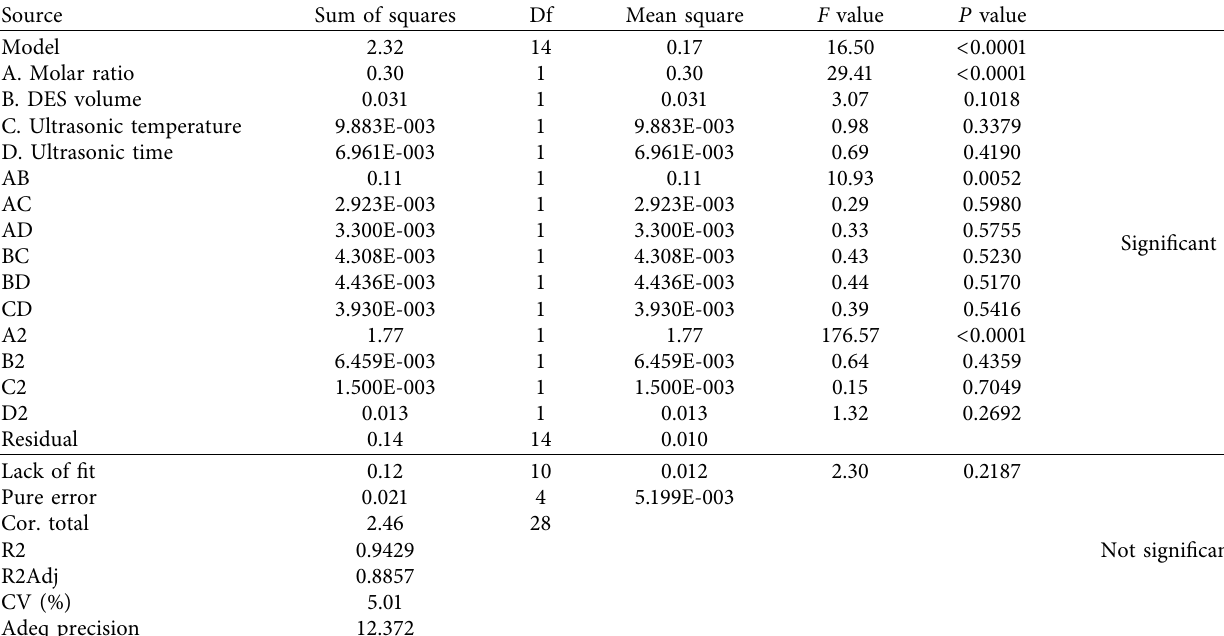
Table 6: Analysis of variance of the regression